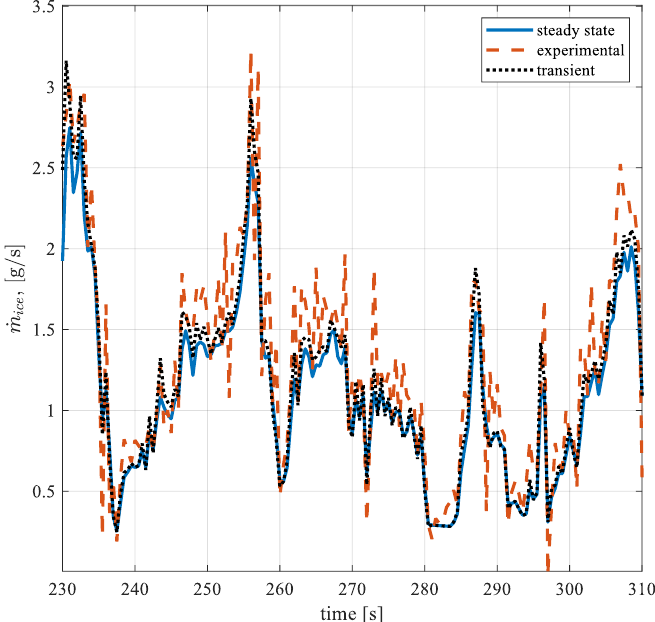
Figure 4. Instant fuel consumption rate from the steady-state map, the experiment, and the model including TCF. Appl. Sci. 2022 , 12 , x FOR PEER REVIEW